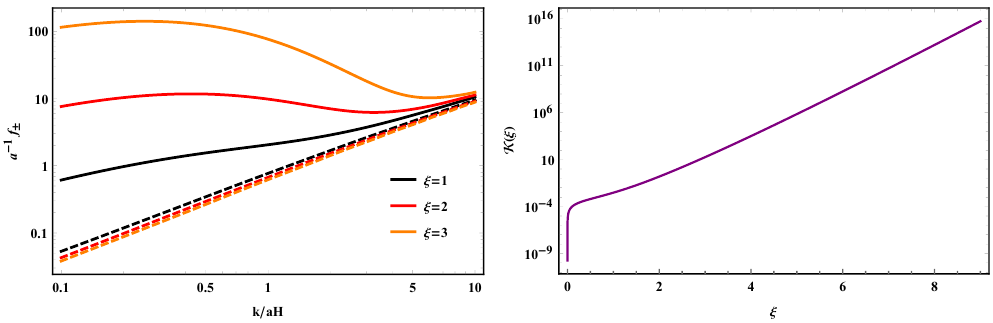
Figure 3 . The SU(2) R gauge boson and right-handed fermion production in type- I scenarios. Left panel: the polarization states of the SU(2) field vs k for different values of ξ . The plus and R aH minus helecity states are presented with solid and dashed lines respectively. Right panel: the K ( ξ ) parameter which quantify the value of fermion production in